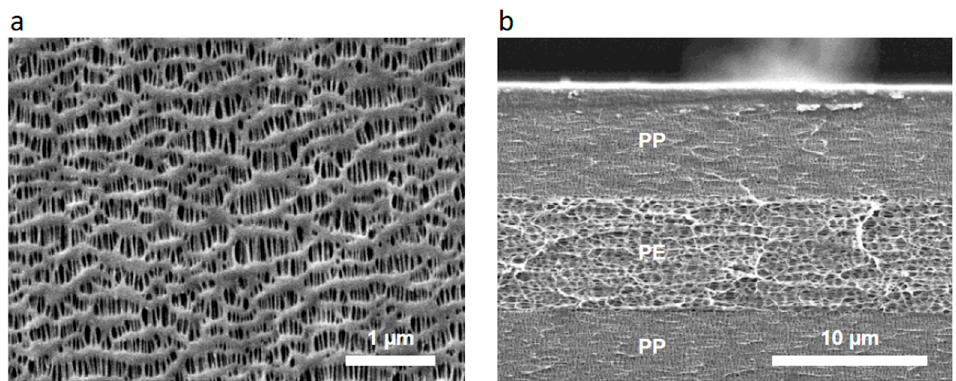
Figure 7. ( a ) Surface and ( b ) cross-sectional scanning electron micrographs of a PP–PE–PP trilayer separator (Celgard 2325). Reproduced with permission from [13].